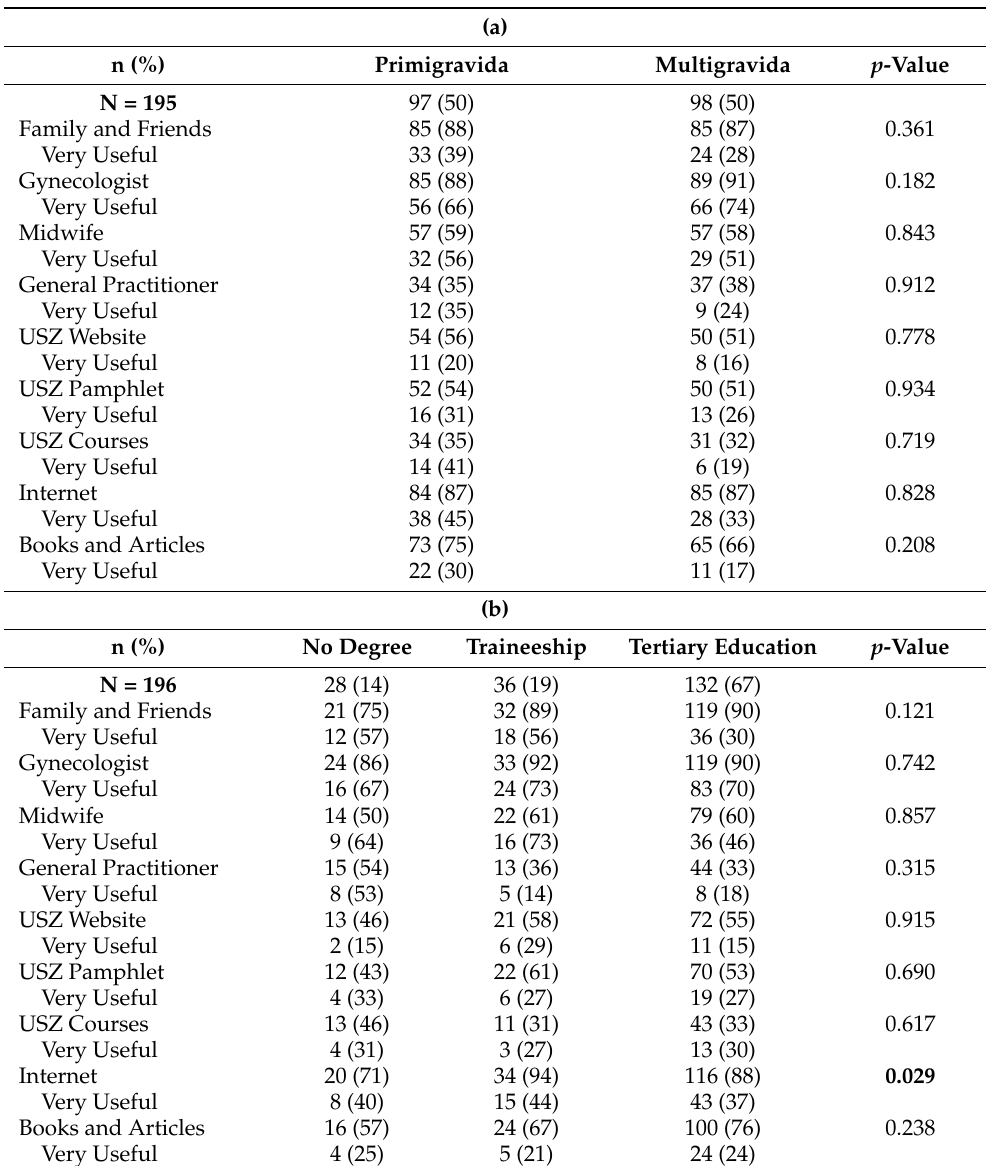
Table 2. (a) Consulted sources and their usefulness regarding the pregnancy, distinguished by number of pregnancies. (b) Consulted sources and their usefulness regarding the pregnancy, distinguished by educational level. Significant results are marked